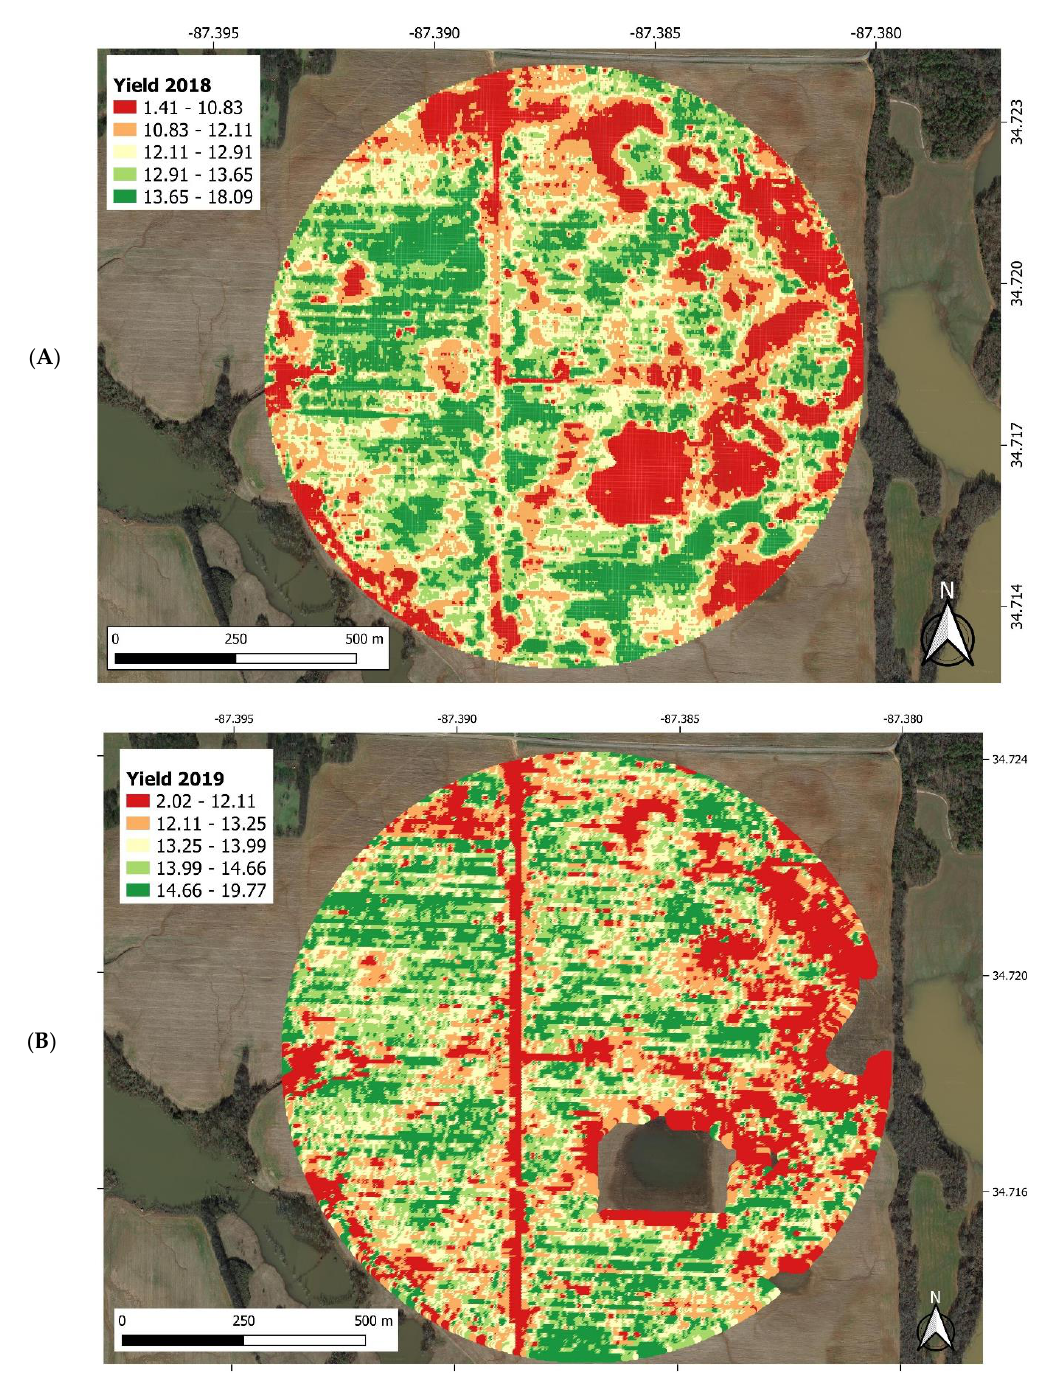
Figure 5. Field variability for yield in 2018 ( A ) and 2019 ( B ) seasons.